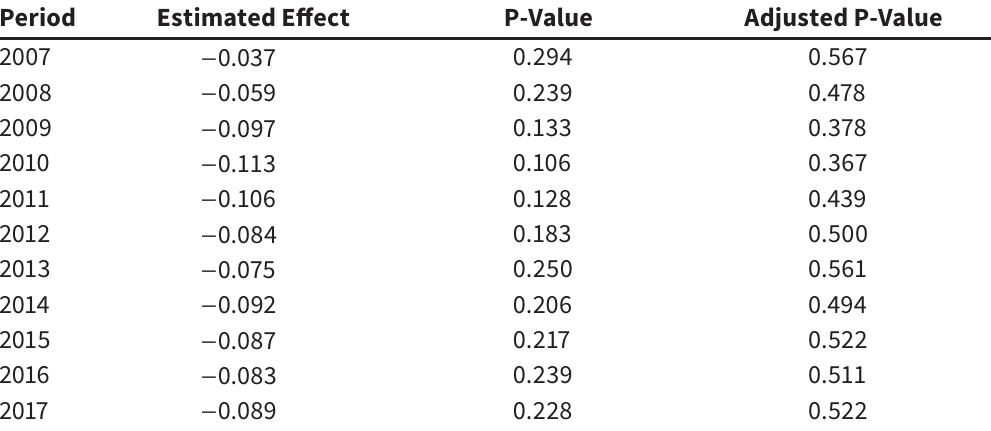
Treatment Effects and Significance for Log Total Employment/Population Ratio in Puerto Rico (Limited Donor Pool)